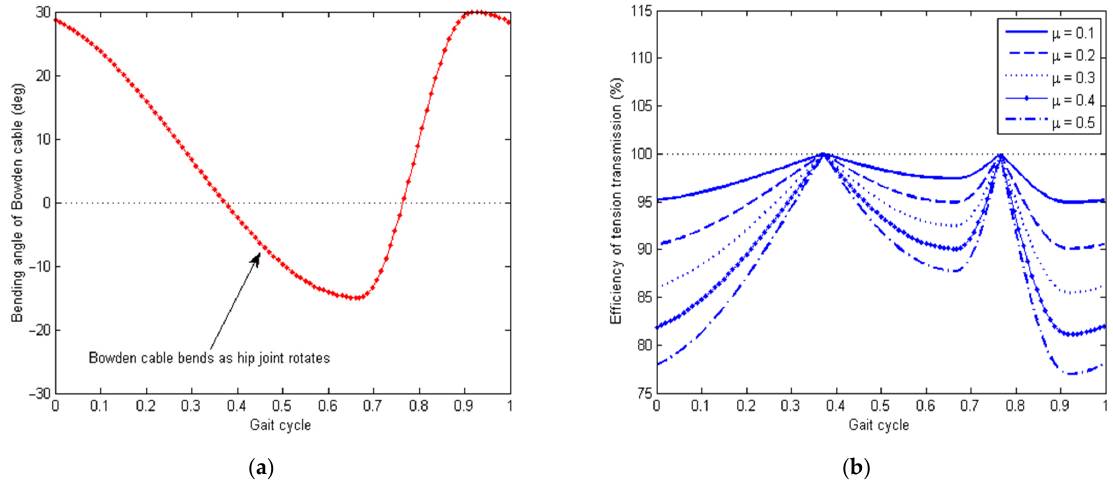
Figure 6. Transmission loss due to Coulomb friction between the inner tendon and outer sheath of the Bowden cable. ( a ) Time history of the bending angle of the Bowden cable caused by the hip joint motion during walking. ( b ) Simulated efficiency of tension transmission of the Bowden cable system.